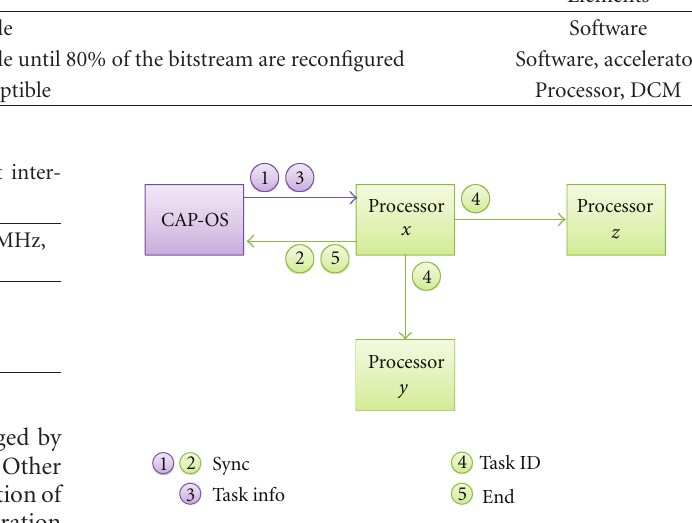
Figure 8: Runtime communication establishment steps between di ff erent